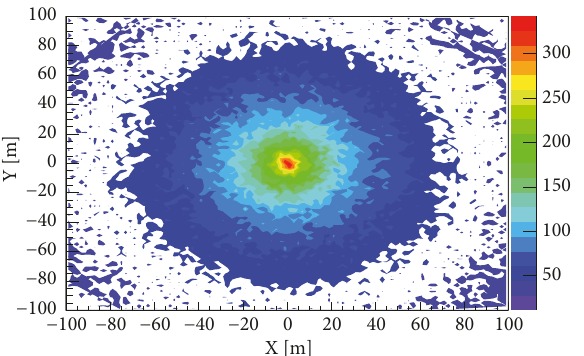
Figure 10: The distribution of secondary muons produced 2.0 Km. above the sea level from the vertical primary proton shower, in X-Y plane.